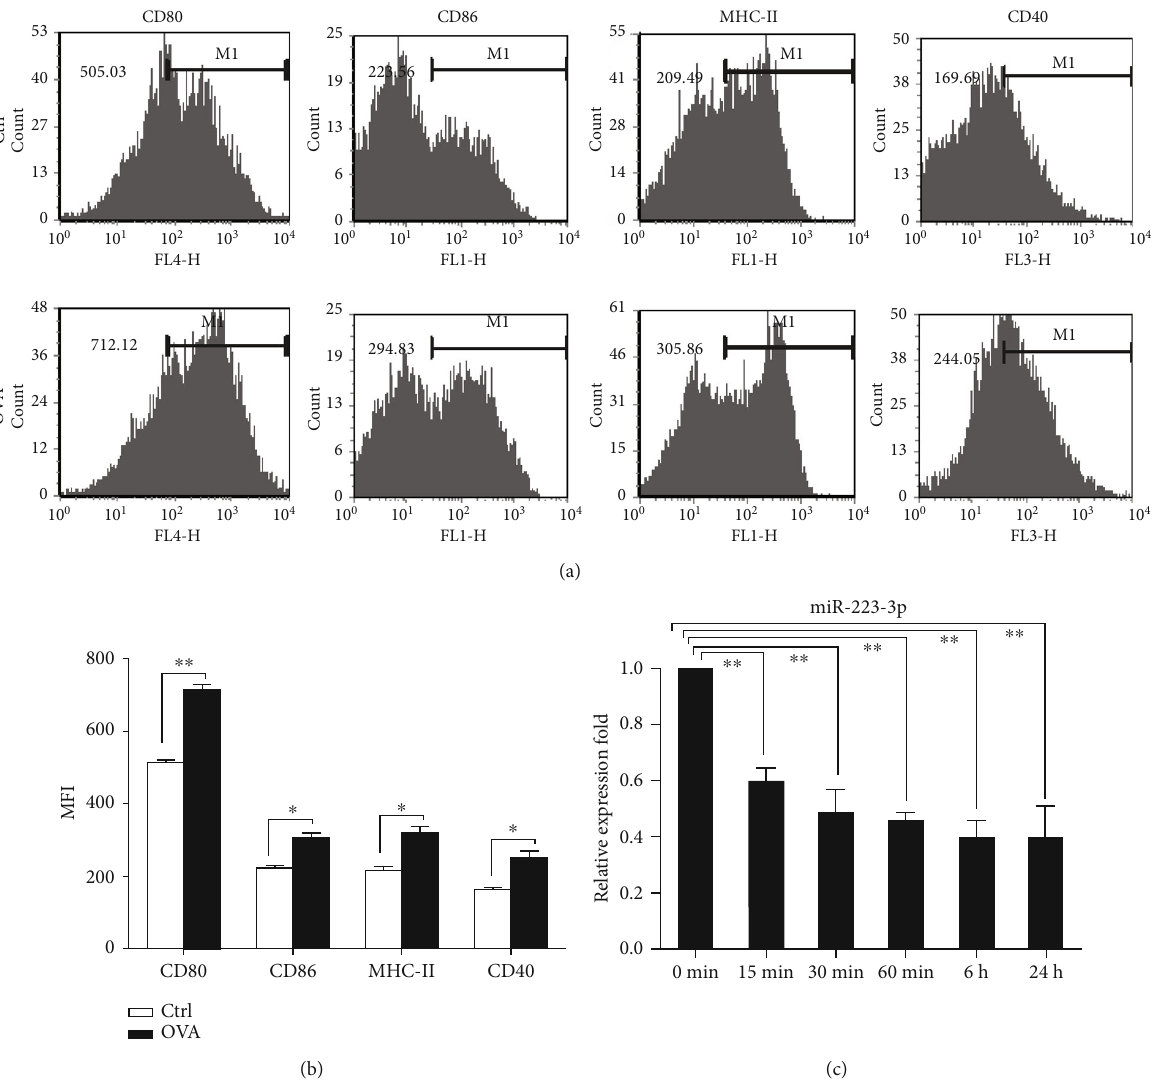
Figure 1: miR-223-3p was downregulated in OVA-induced DCs. (a) Mouse immature DCs were treated with 100 μ g/ml OVA for 24 h and then stained with speci fi c Abs against MHC-II, CD80, and CD86 for fl ow cytometry analysis. (b) The bar chart indicated the MFI of the DCs in each group. t -test, ∗ P < 0 : 05 , compared to the control group. (c) miR-223-3p expression in OVA-treated immature DCs. Immature DCs were incubated with OVA (100 μ g/ml) for 24h. Cells were collected at the indicated time points, and miR-223-3p expression was determined by RT-PCR. Data were shown as mean ± SD of three independent experiments. Post hoc Tukey ’ s HSD test, ∗ P < 0 : 05 , ∗∗ P < 0 : 01 , compared to the 0 min